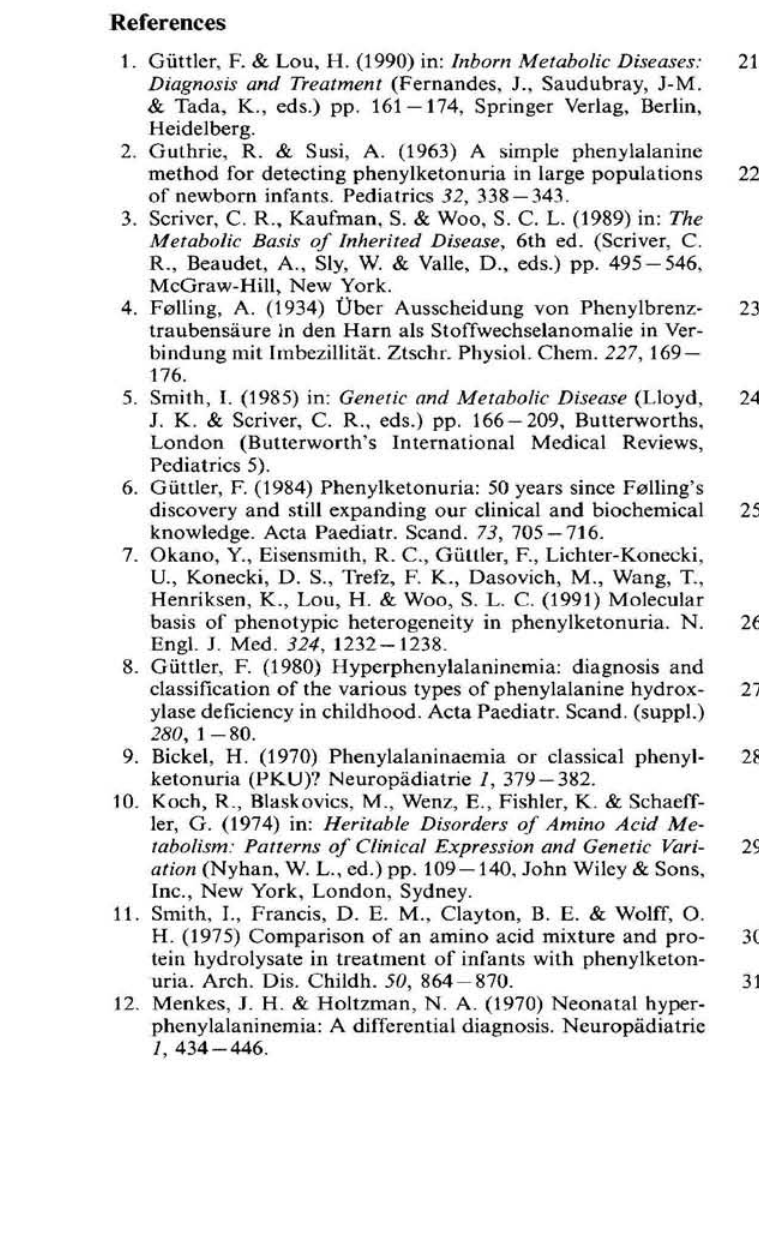
tabolism: Patterns of Clinical Expression and Genetic Vari- ation (Nyhan, W. L., ed.) pp. 109-140, John Wiley &